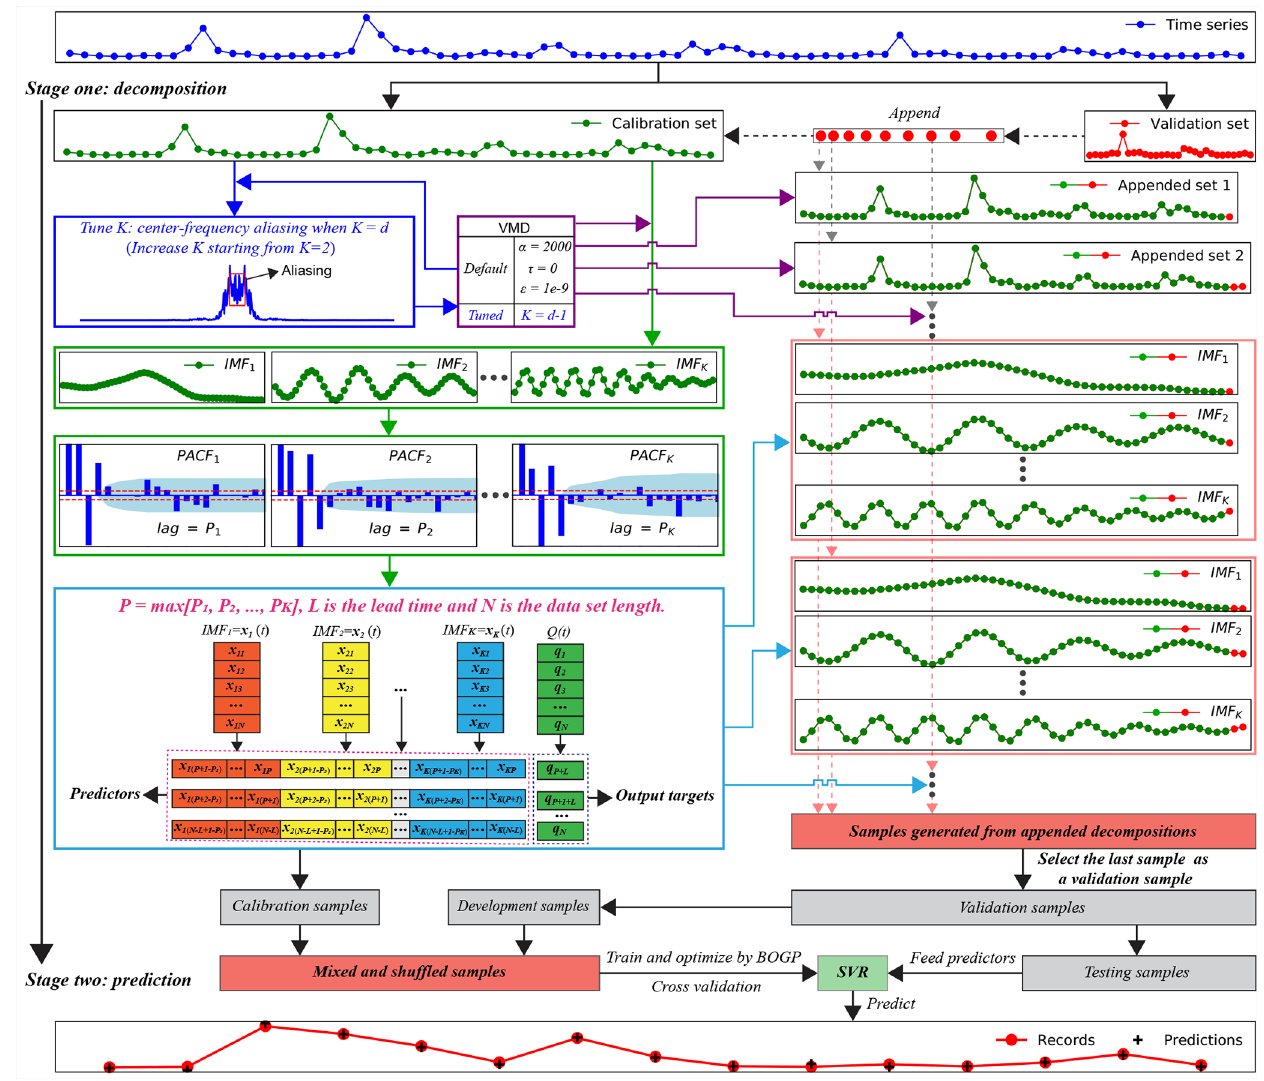
Figure 6. A block diagram of the two-stage decomposition prediction (TSDP) framework with the VMD-SVR